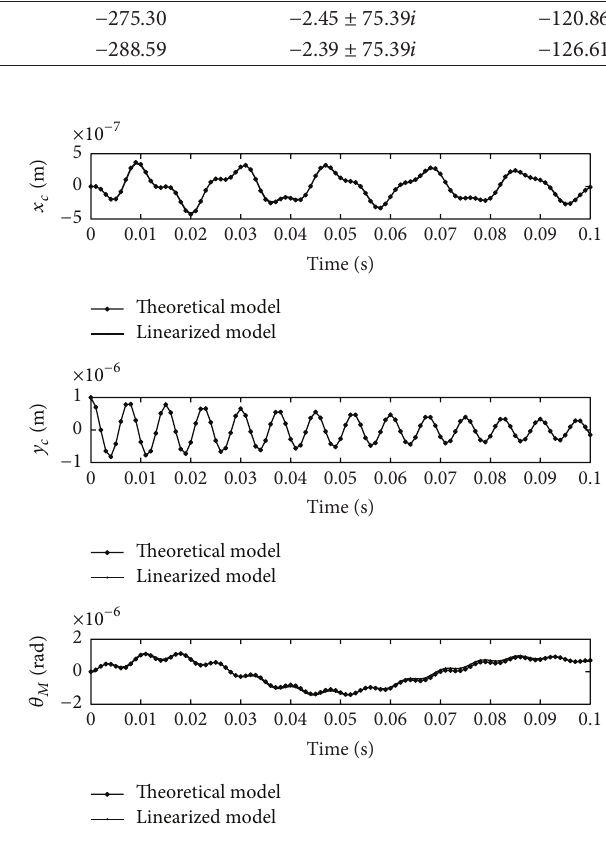
Figure 6: Accuracy verification of linearized dynamic rolling process